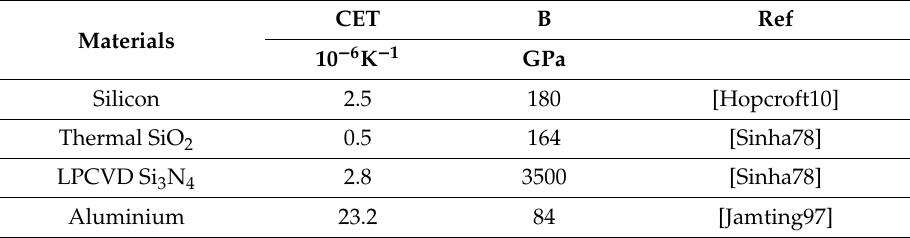
Table 1. Coe ffi cient of thermal expansion and biaxial elastic module G of various materials used in 3D